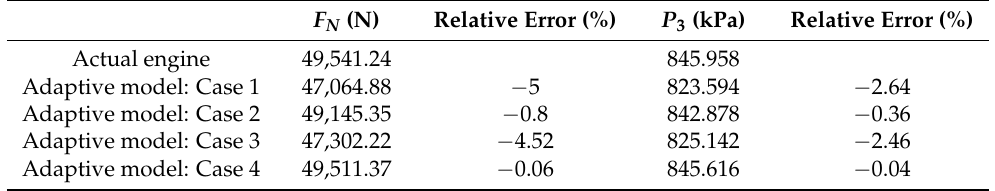
Table 7. Simulation and comparison results of operating condition ( H = 1000 m, Ma = 0.05, PLA = 22°).